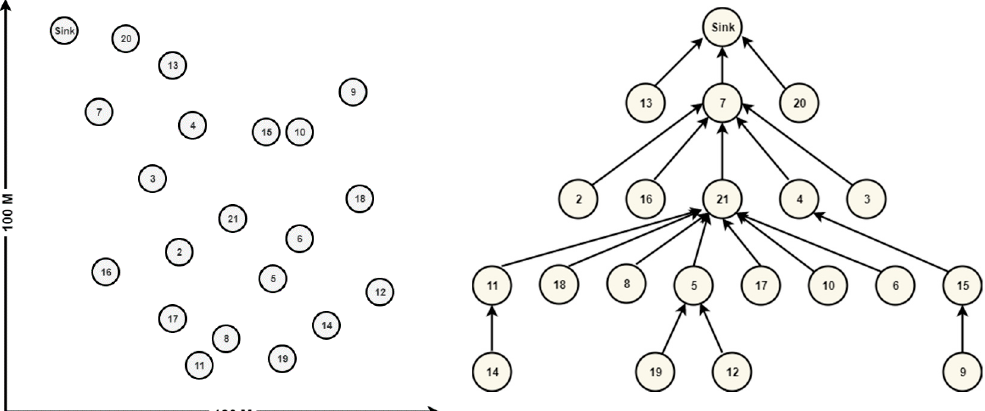
Figure 1. Simulation scenario and network graph based on the RPL routing protocol.